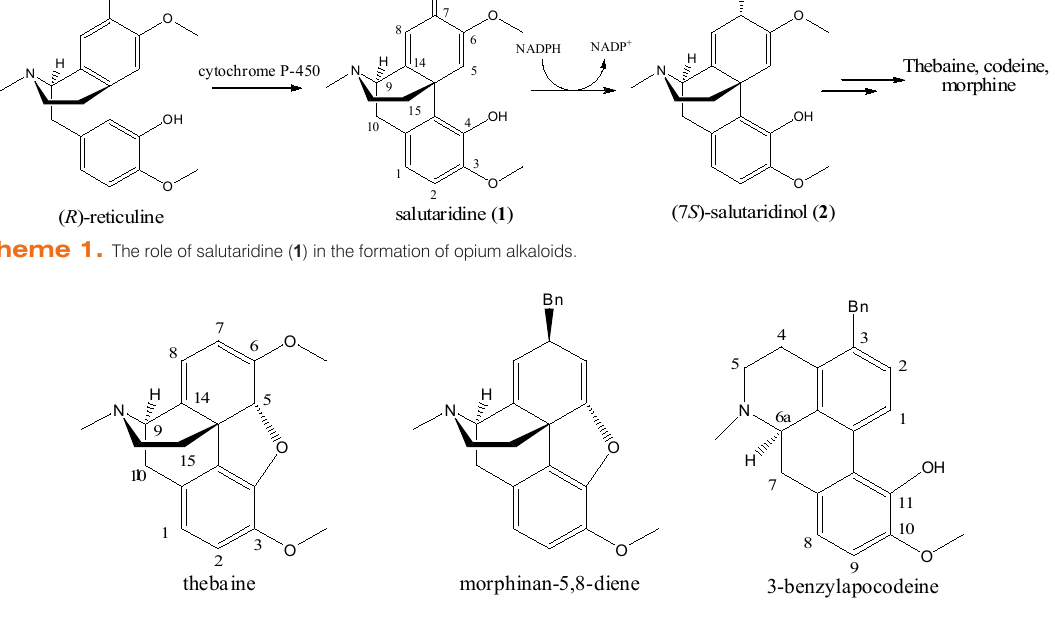
Figure 1. Stucture of morphinandienes and their acid-catalyzed rearrangement product,